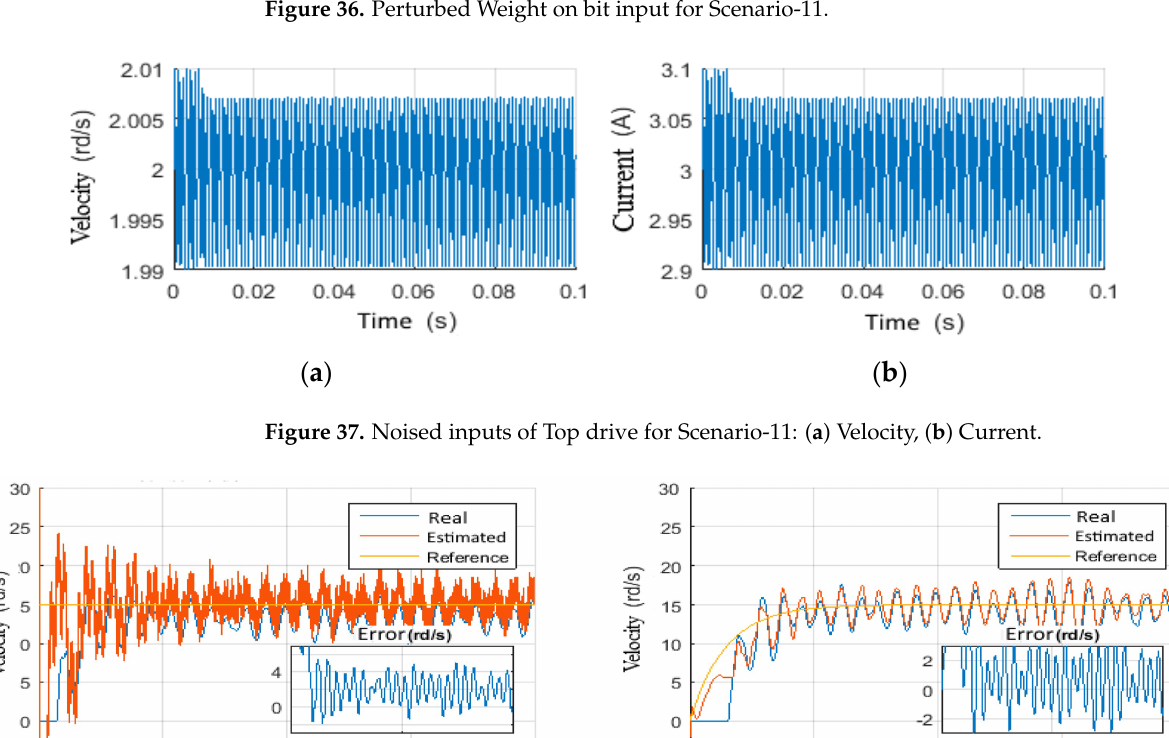
Figure 36. Perturbed Weight on bit input for Scenario-11.